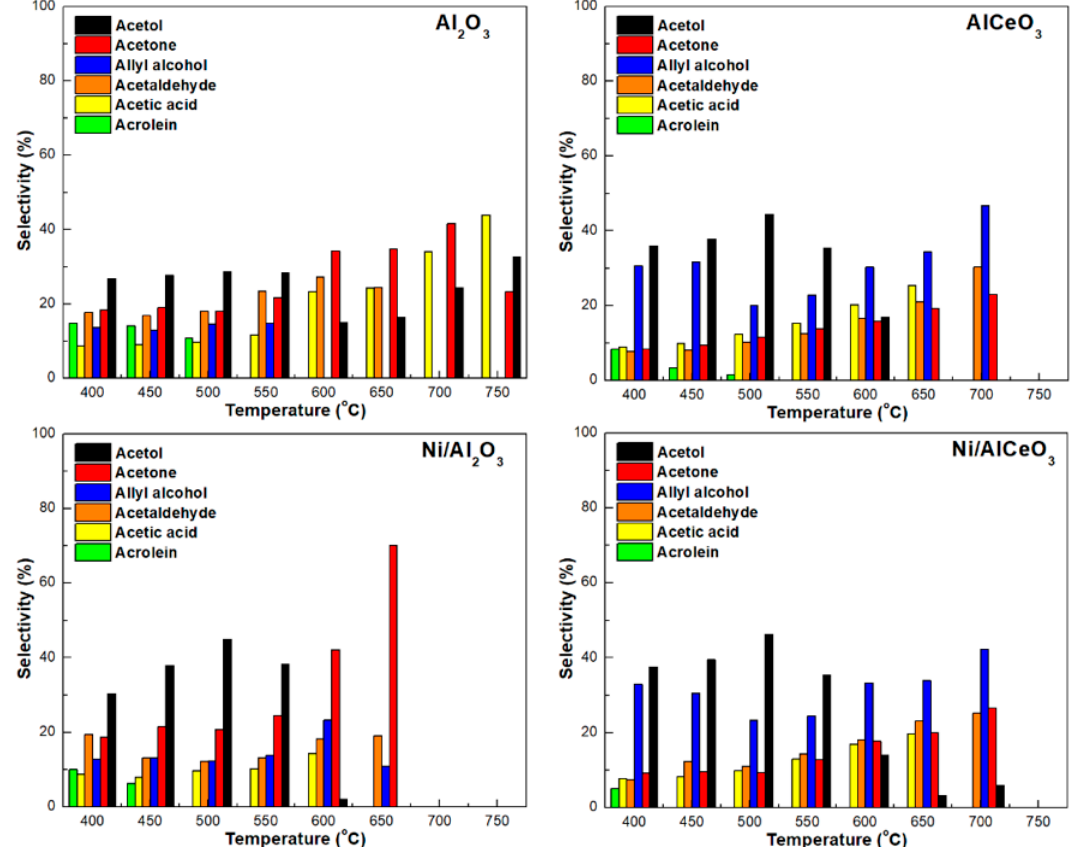
Figure 8. Liquid product selectivity for all samples tested herein (samples tested under experimental protocol #1).